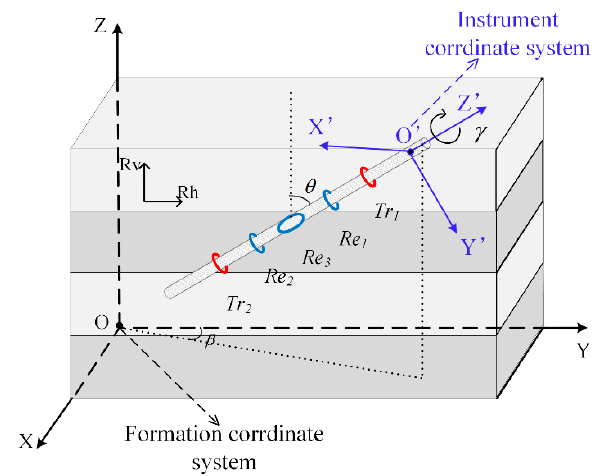
Figure 1. Schematic diagram of the logging while drilling (LWD) instrument used in this study.